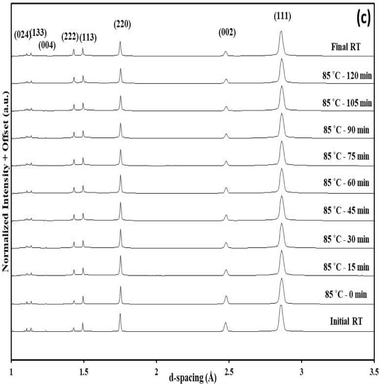
Full Debye-Scherrer rings of the pure Pb foil at 85 ◦C at (a) 0 and (b) 120 min. Some textural changes that occurred in the foil during the temperature hold are highlighted by ellipses. (c) Integrated 1-D diffraction patterns from a pure Pb foil during isothermal holding at 85 ◦C, where only patterns at every 15 min interval are shown.